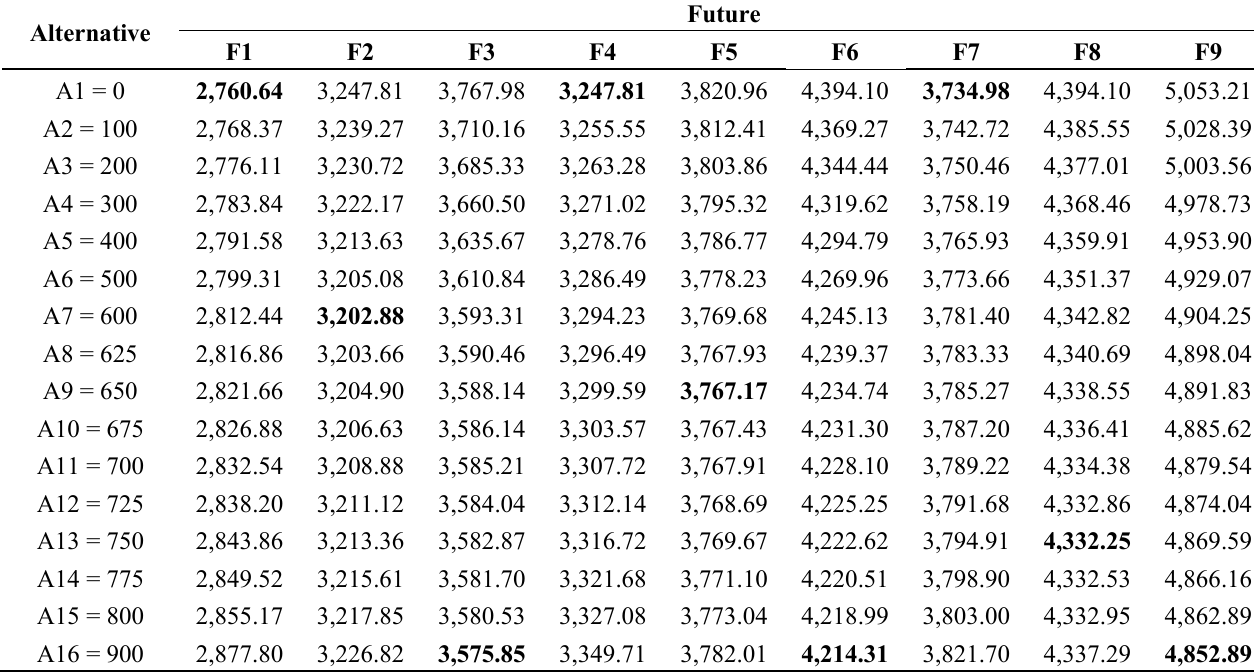
Table 4. Decision matrix: total cost (k$)—Case